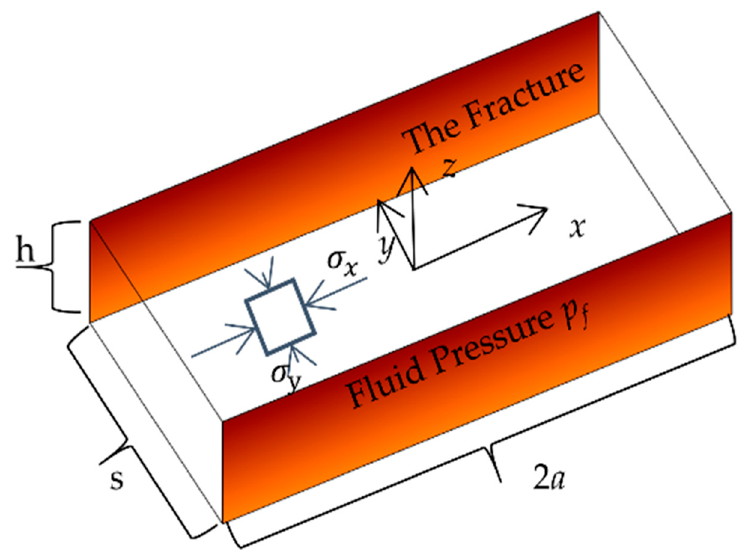
Figure 2. The validation problem of comparing this work to Kresse, Weng, Gu and Wu [30] and FLAC3D: two parallel straight fractures.